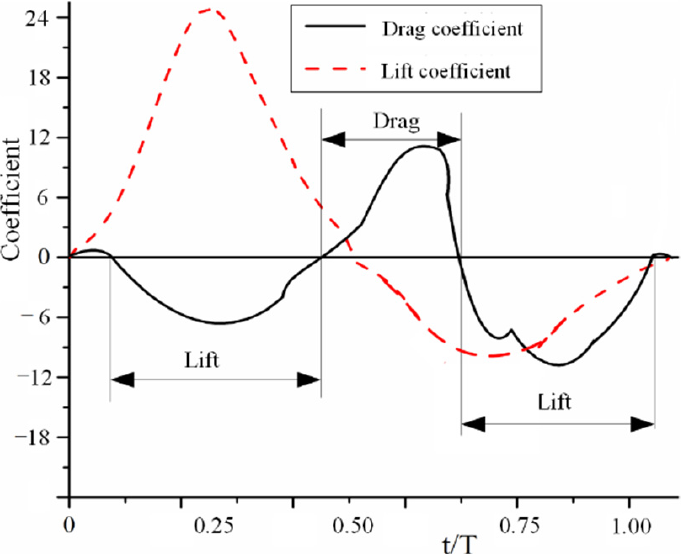
Figure 7. Force change of C L and C D with the time for the flapping of hindwings.